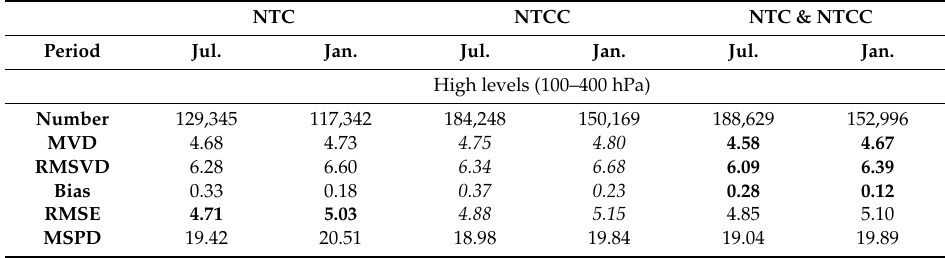
Table A5. Comparisons between GK-2A clear-air AMVs for CH08 and GDAPS over the full-disk area for July 2016 and January 2017. The NTC, NTCC methods, and their combination were used for producing GK-2A AMVs, considering QIF > 80. The best scores are in bold and the worst scores are in italics.